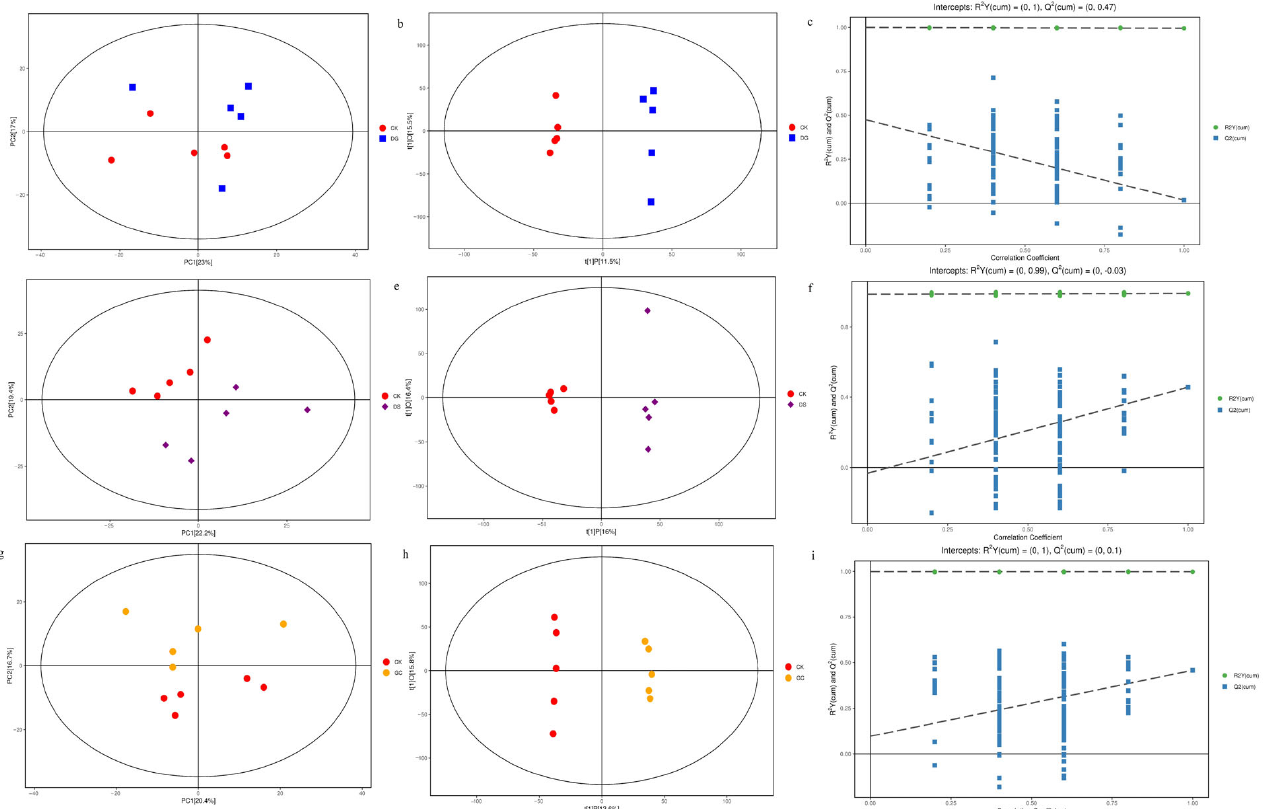
Figure 4. Principal component analysis (PCA) model score scatter plot, orthogonal partial least- squares discriminant analysis (OPLS-DA) model, and permutation test: ( a – c ) were derived from yak calves consuming Angelica sinensis and control calves, ( d – f ) were derived from yak calves consuming Codonopsis pilosula and control calves, and ( g – i ) were derived from yak calves consuming Glycyrrhiza uralensis and control calves.